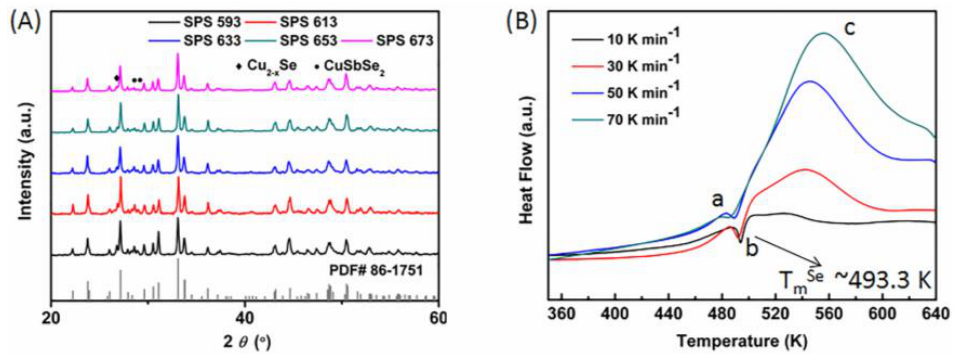
Figure 1. ( A ) X-ray diffraction (XRD) patterns of all the bulk samples; and ( B ) differential scanning calorimeter (DSC) of the powders with different heating rates.